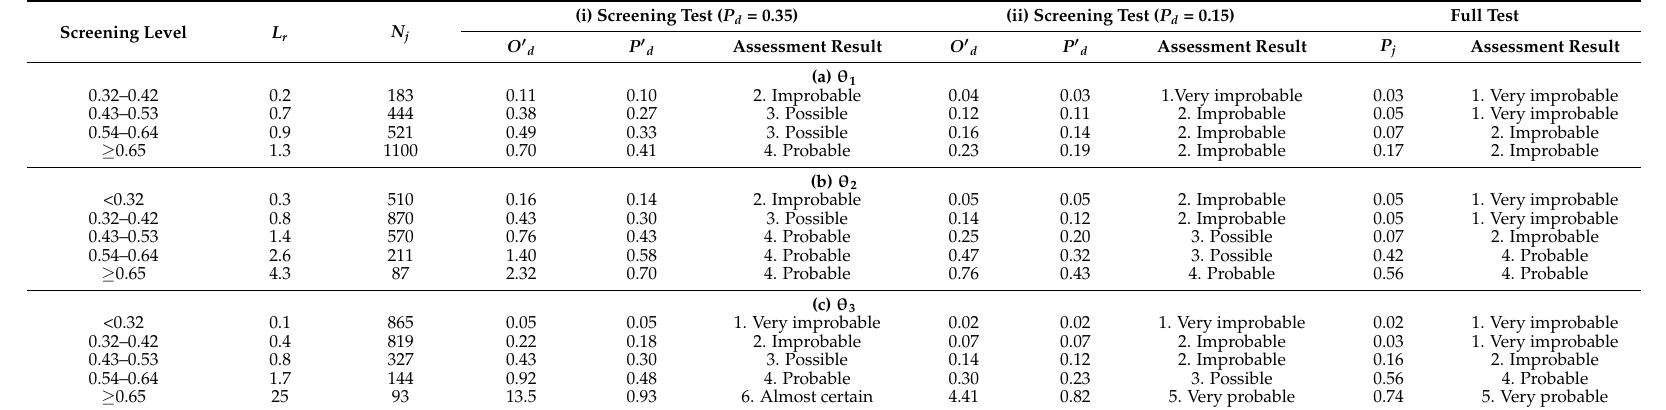
Table 3. Screening levels and assessment results of 2248 offices.